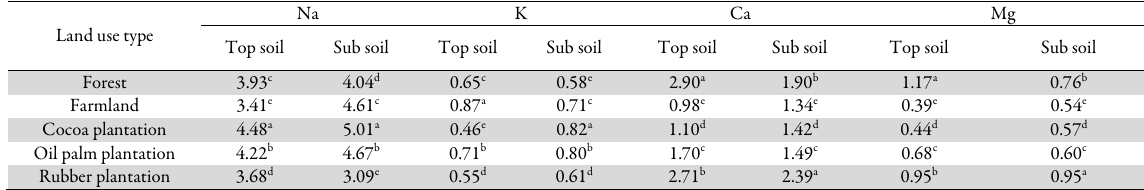
Table 3. Exchangeable cations (Na, K, Ca and Mg in mg kg -1 ) at top and sub soil in five different land use types Land use